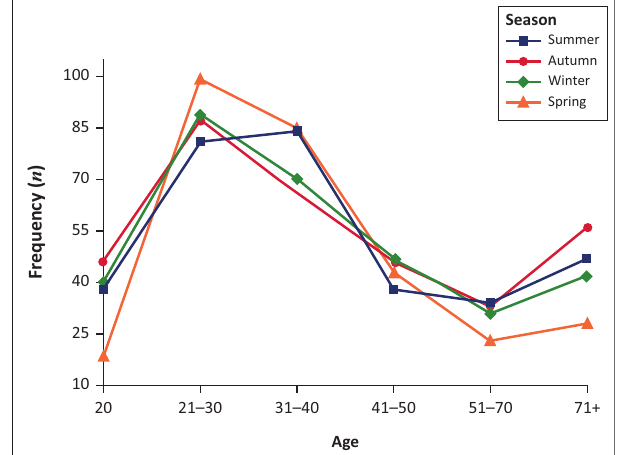
FIGURE 1 : Daily variations in suicide by age in males.